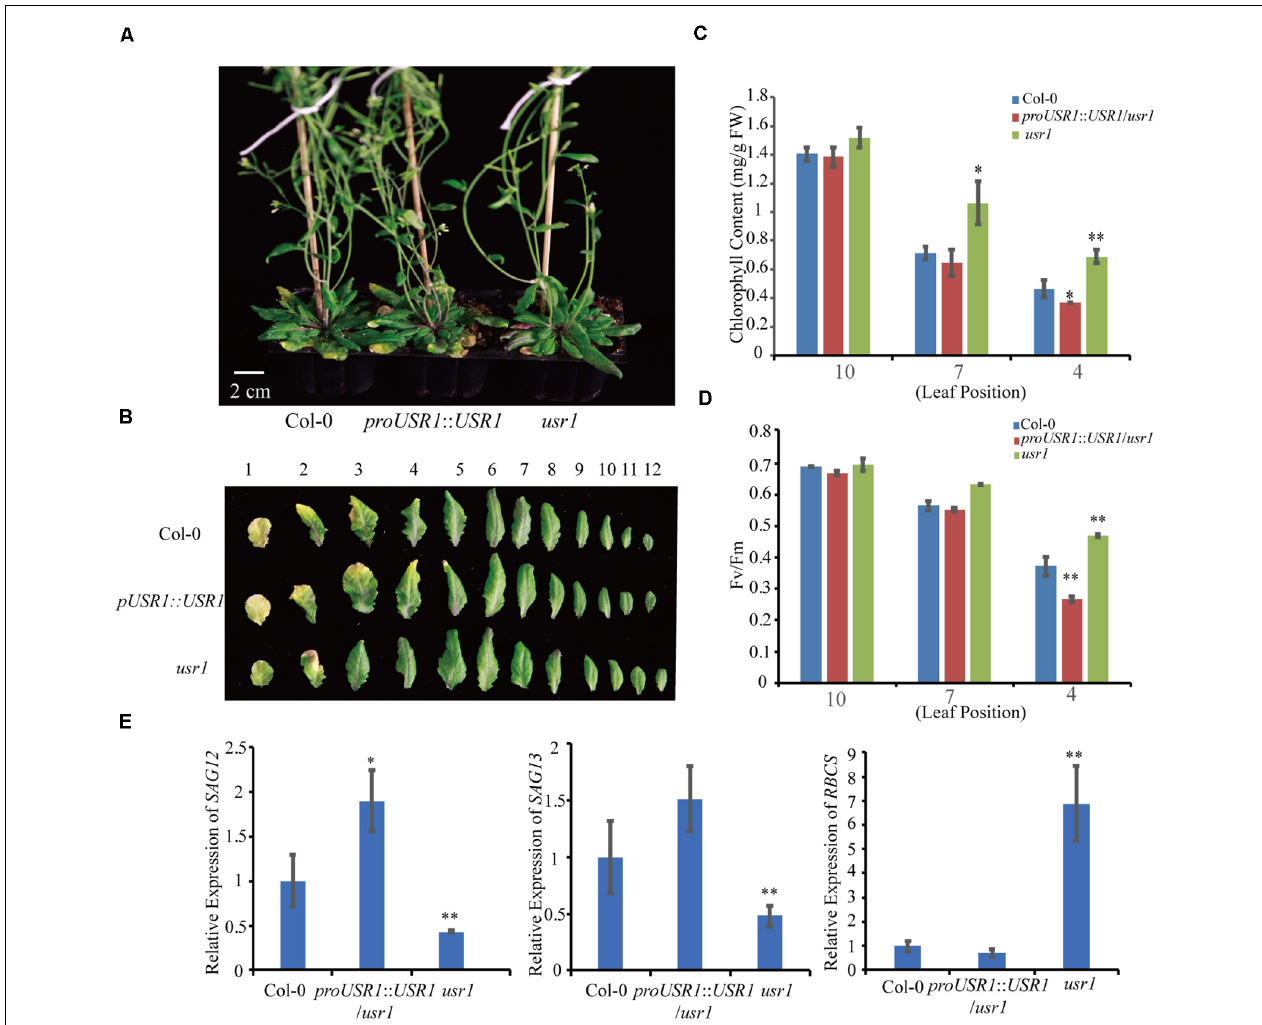
FIGURE 2 | The usr1 mutant plants show delayed leaf senescence. (A) The senescence phenotype of plants with different genotype as indicated after grown under continuously light for 40 days. usr1 mutant shows delayed leaf senescence and complementation plants proUSR1 :: USR1 / usr1 rescued the delayed leaf senescence phenotype of usr1 plants. (B) Senescence phenotypes of detached 1st–12th leaves of different genotypes as indicated. (C,D) Chlorophyll content and Fv/Fm detection of leaves from different leaf positions in Col-0, usr1 , and proUSR1 :: USR1 / usr1 plants as indicated. (E) Expression of SAGs genes including SAG12 , SAG13 , and RBCS in plants of different genotypes as indicated. Single and double asterisk indicate significant difference at 0.01 < P < 0.05 and P < 0.01 levels using student’s t -test. Data are shown as the mean ± SD from three independent